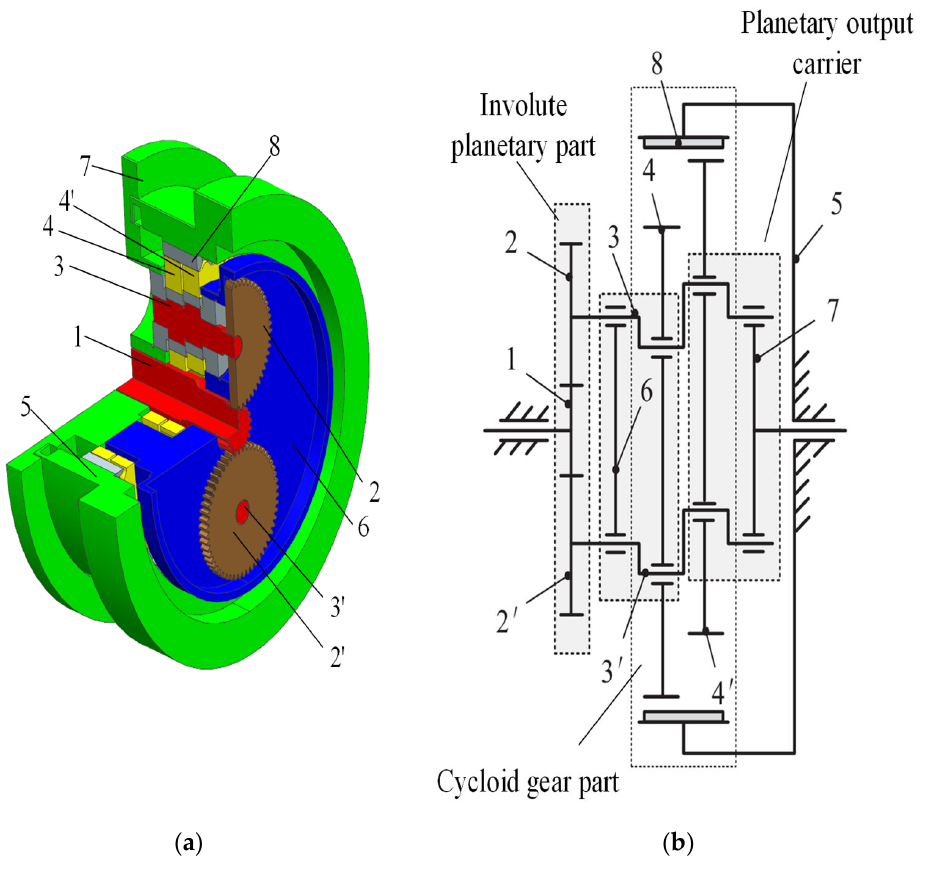
Figure 1. Schematic diagram of RV-40E reducer structure principle. ( a ) The structure of RV reducer; ( b ) Description of what is contained in the second panel. 1. Input shaft with sun gear; 2 (2 ′ ). Planetary gear; 3 (3 ′ ). Crankshaft; 4 (4 ′ ). Cycloid gear; 5. Needle tooth shell; 6. Planet carrier; 7. Flange plate; 8. Needle gear.